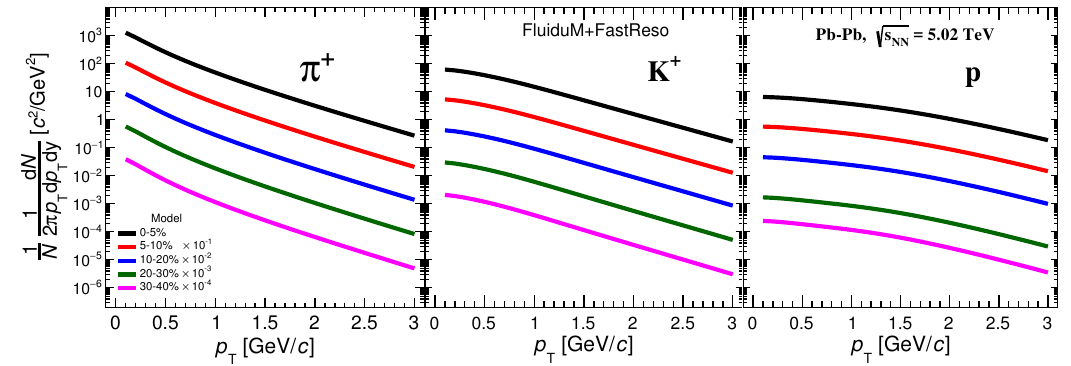
Figure 7 . Predictions for the p T -di(cid:11)erential spectra of pions (left panel), kaons (middle panel) and p protons (right panel) in Pb-Pb collisions at s NN = 5.02 TeV, in (cid:12)ve centrality classes.